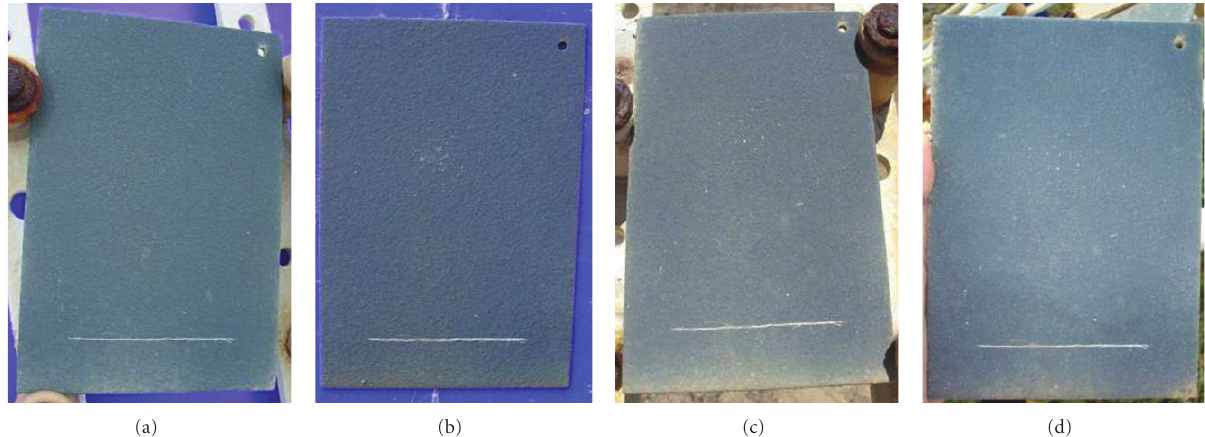
Figure 4: Thermal-sprayed coating of Zn/Al by flame process, sealed with wash primer (445 μ m). (a) 12 months of exposure. (b) 24 months of exposure. (c) 36 months of exposure. (d) 48 months of exposure.